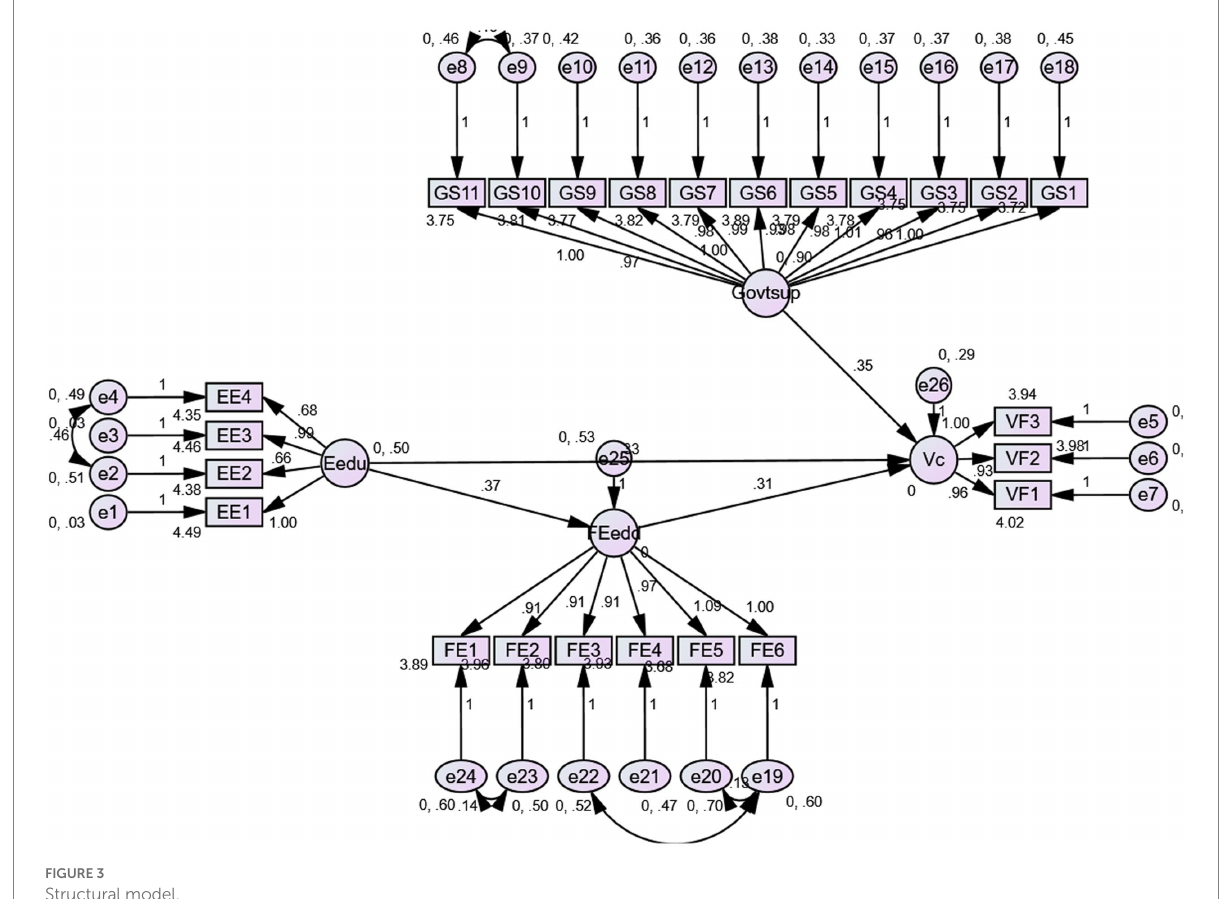
FIGURE 3 Structural model.